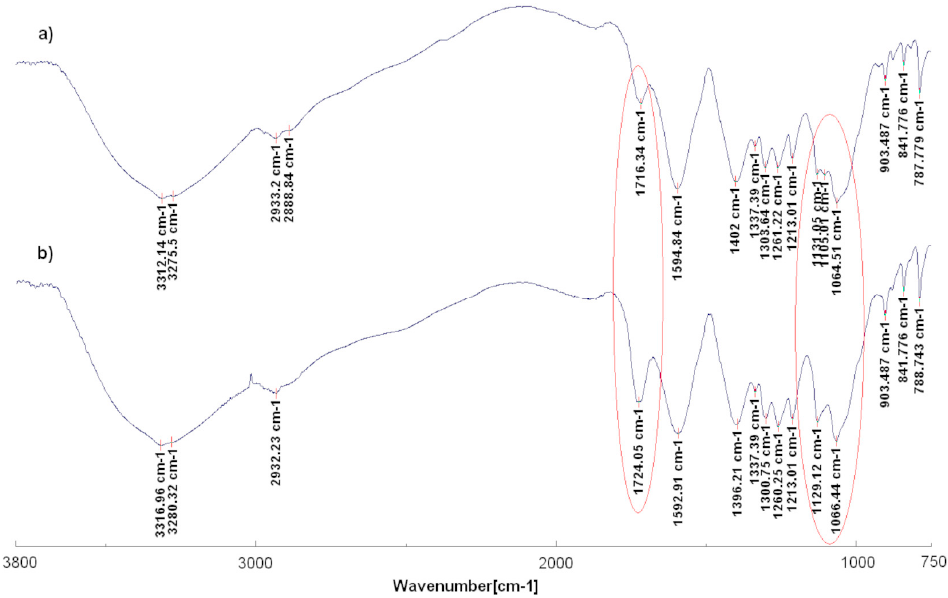
Figure 4. FTIR spectra of grape marc extract GM2 ( a ) and Ir-NP2 ( b